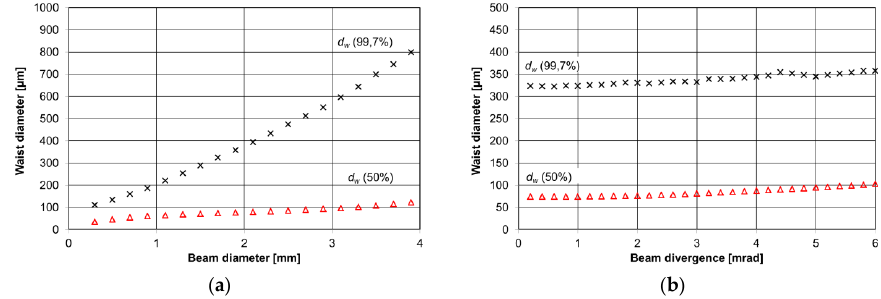
Figure 4. ( a ) Simulation results of beam diameter; and ( b ) divergence of a 4 mm beam influence on a waist diameter d w inside a four mirror bow-tie cavity.